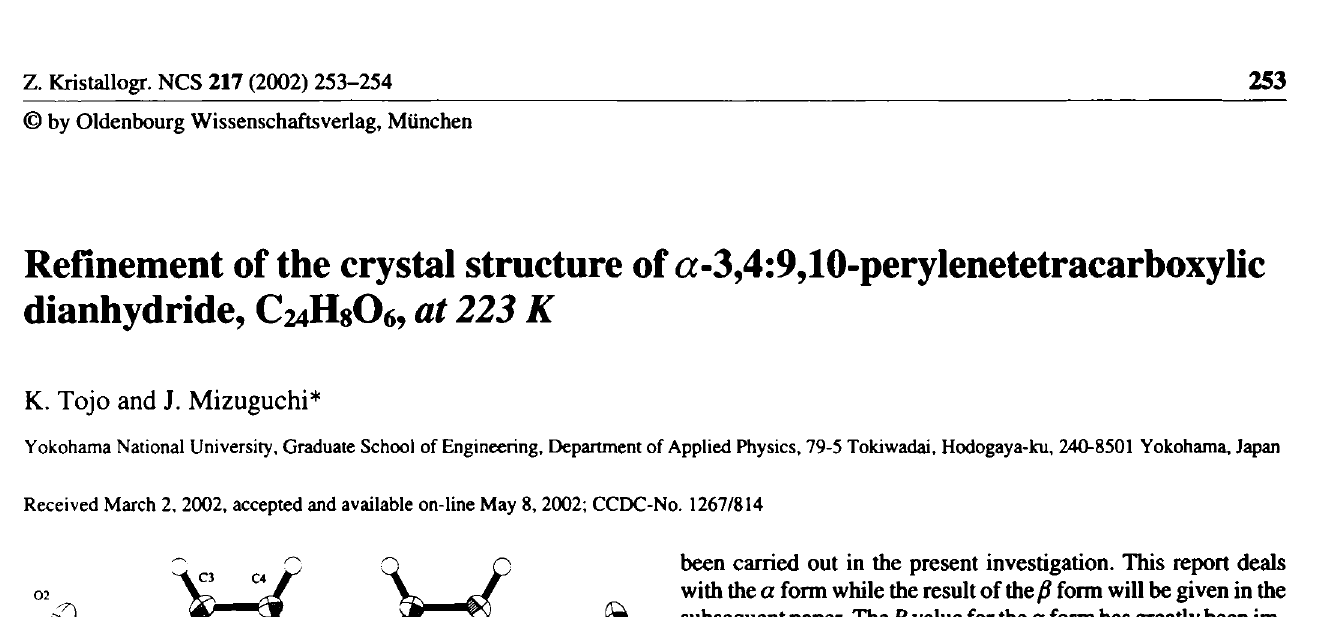
Table 1. Data collection and handling. Crystal: